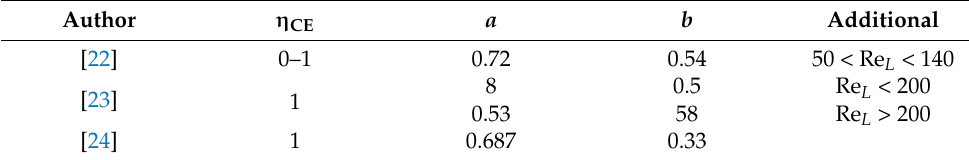
Table 1. Parameters for the Equation (14) by different